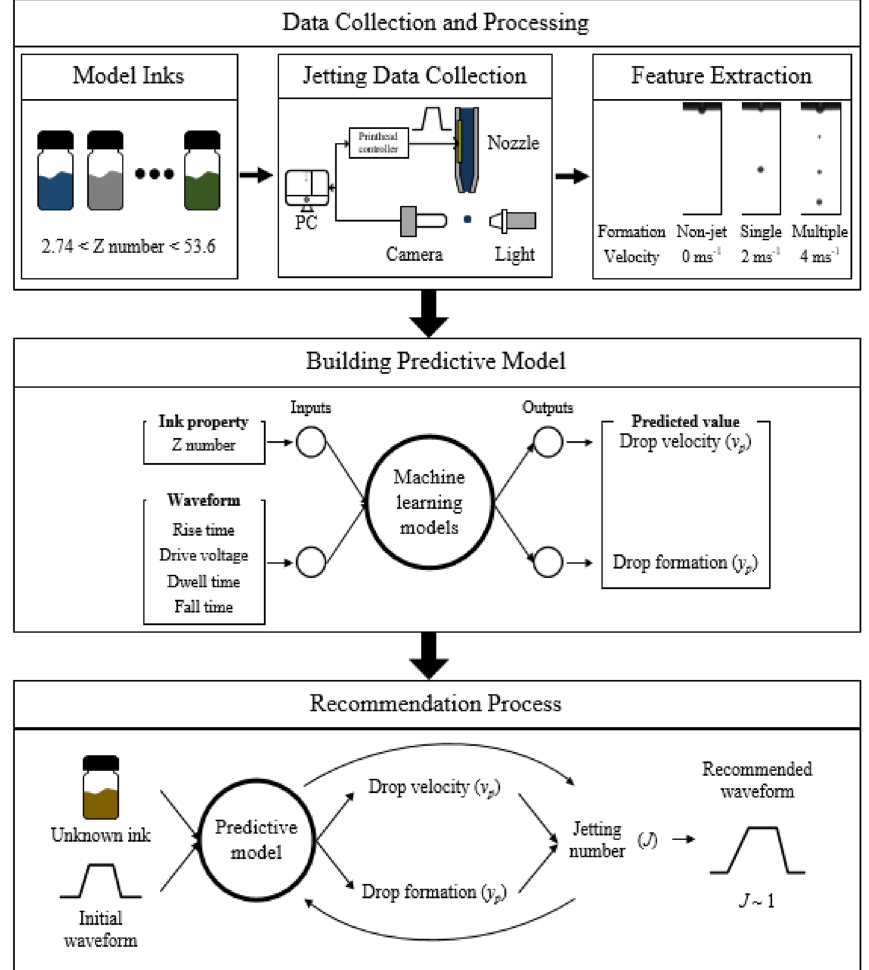
Figure 1. Schematic representation of the working flow for designing an optimized inkjet drive waveform using machine learning